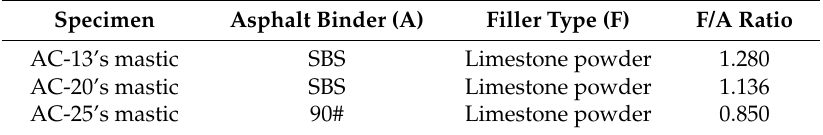
Table 4. Compositions of asphalt mortar containing find aggregates, filler and asphalt binder.